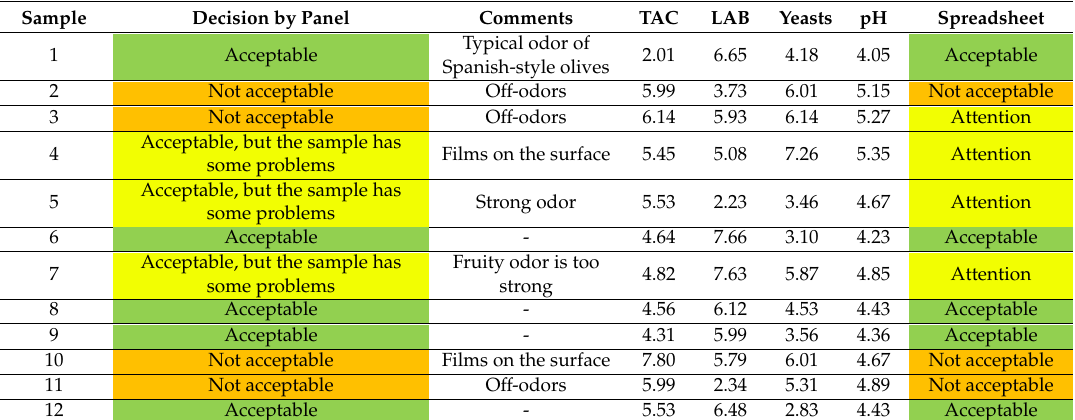
Table 2. Decision on the samples used for the validation.